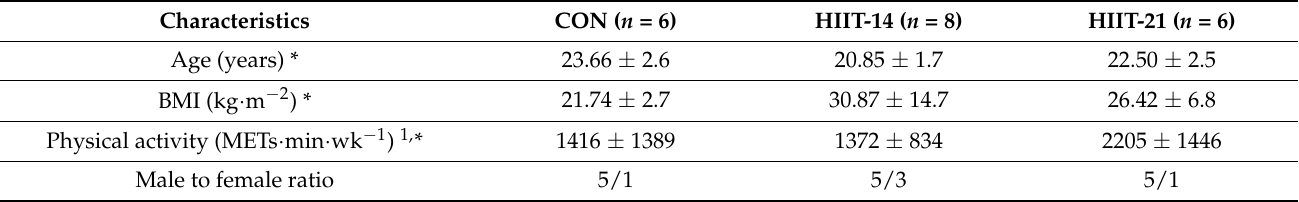
Table 1. Demographic characterization of the participants.